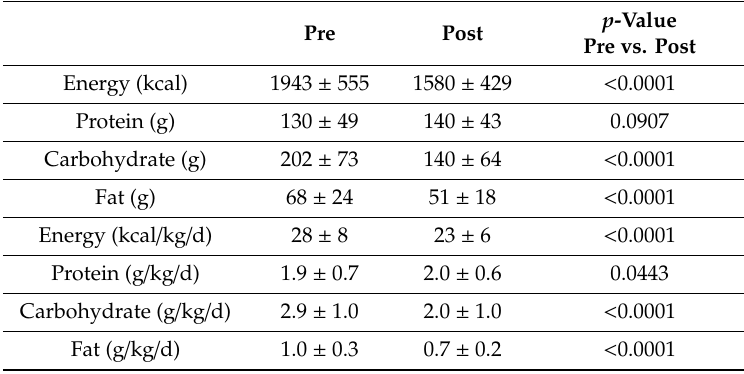
Table 2. Energy and Macronutrient Intake.